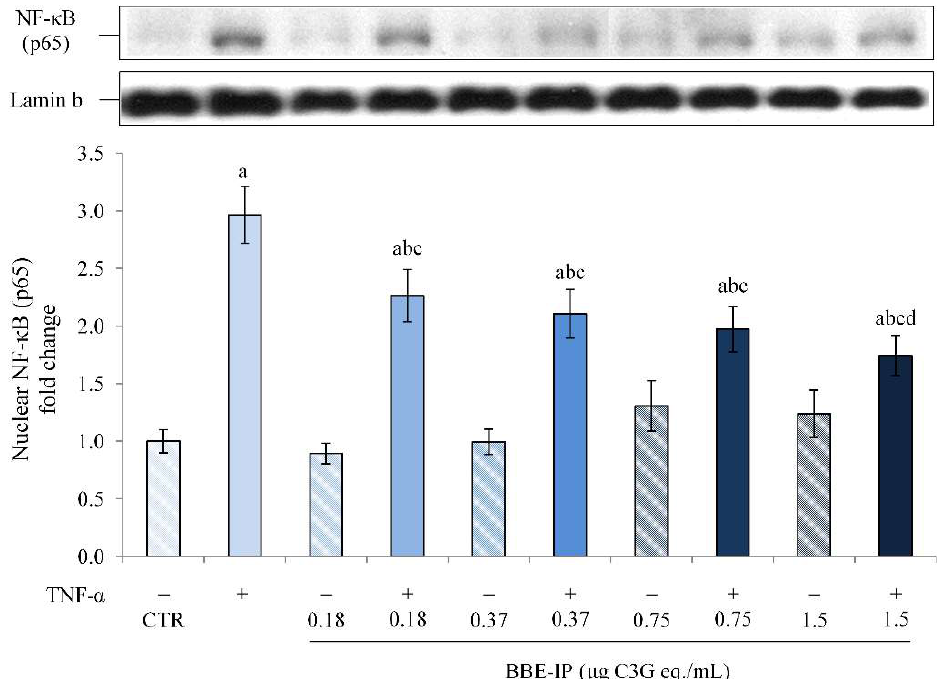
Figure 4. Nuclear NF- κ B (p65). Differentiated Caco-2 cells were pretreated or not for 24 h with different concentrations of the BBE-IP (0.18, 0.37, 0.75, 1.5 µ g C3G eq./mL). Cells were subsequently exposed to 50 ng/mL TNF- α for 6 h. Cells treated with the vehicles alone were used as controls (CTR). Results are reported as fold change against CTR and expressed as mean ± SD of three independent experiments. p65 values were normalized to the corresponding Lamin b value. a p < 0.05 vs. CTR; b p < 0.05 vs. TNF- α ; c p < 0.05 vs. same BBE-IP dose unexposed to TNF- α ; d p < 0.05 vs. BBE-IP 0.18 exposed to TNF- α.